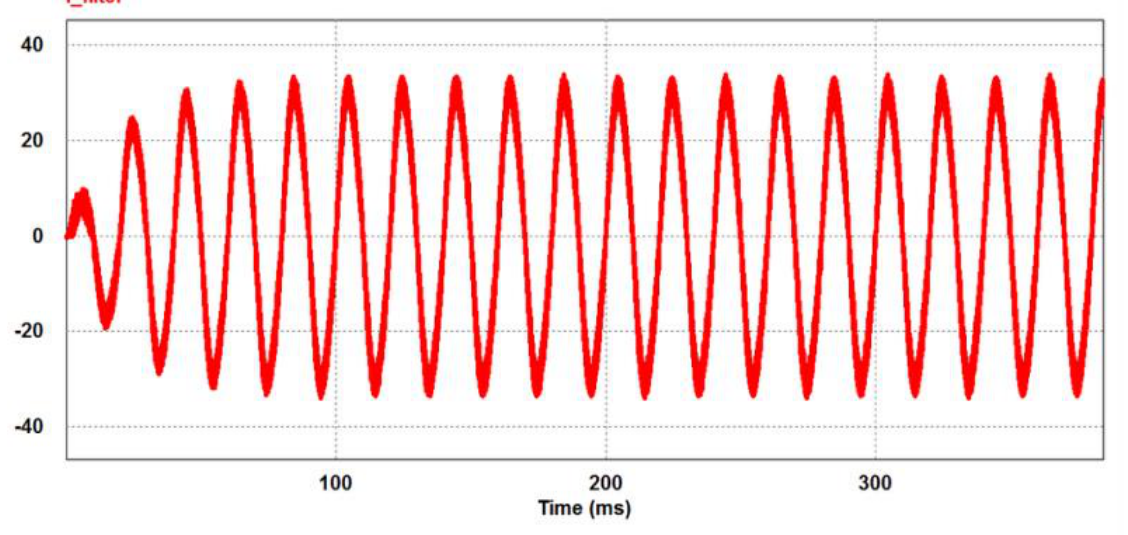
Figure 7. The input current waveform of IH system with Boost PFC